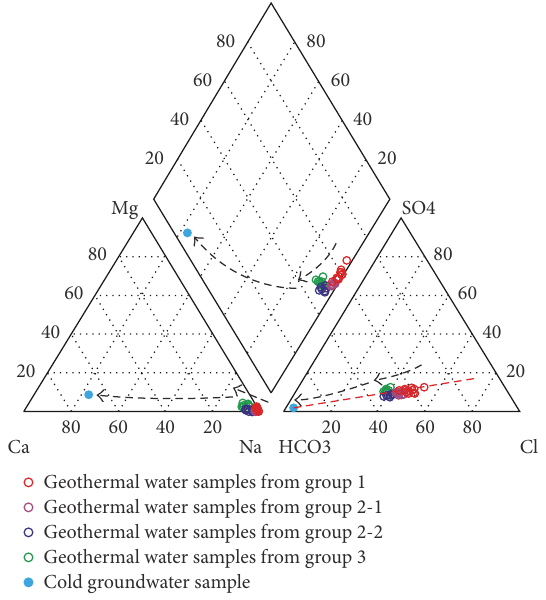
Figure 5: Piper diagram of geothermal spring samples in the research